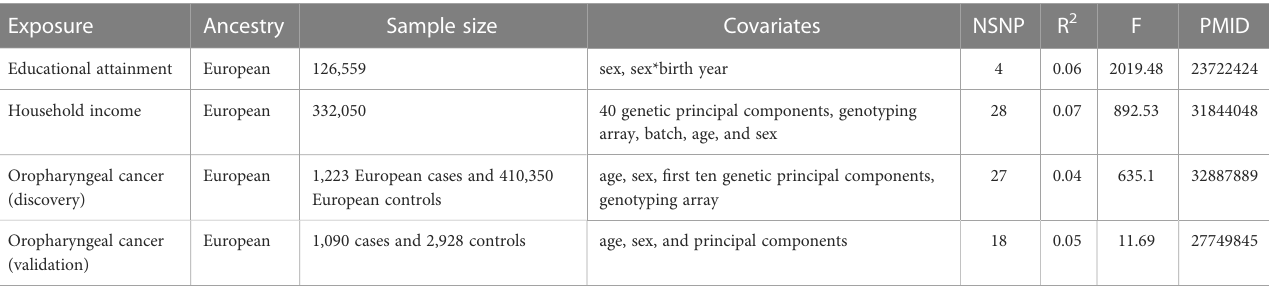
TABLE 1 A summary of genome-wide association